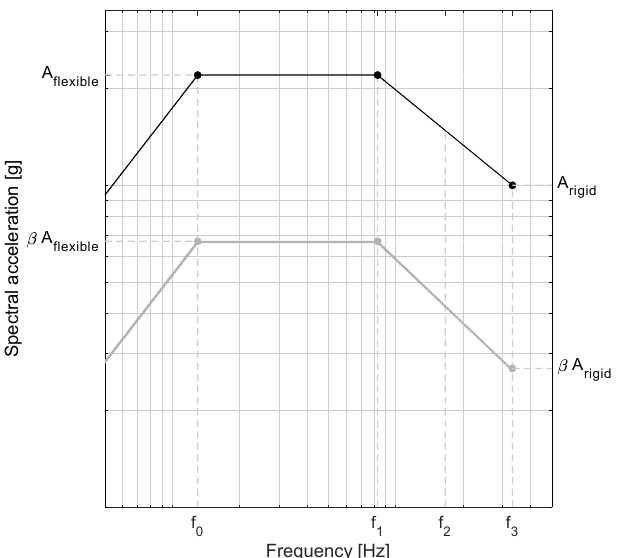
Figure 13. Required response spectra in the horizontal (black) and vertical (grey) directions according to ISO 13033, 5% damped.